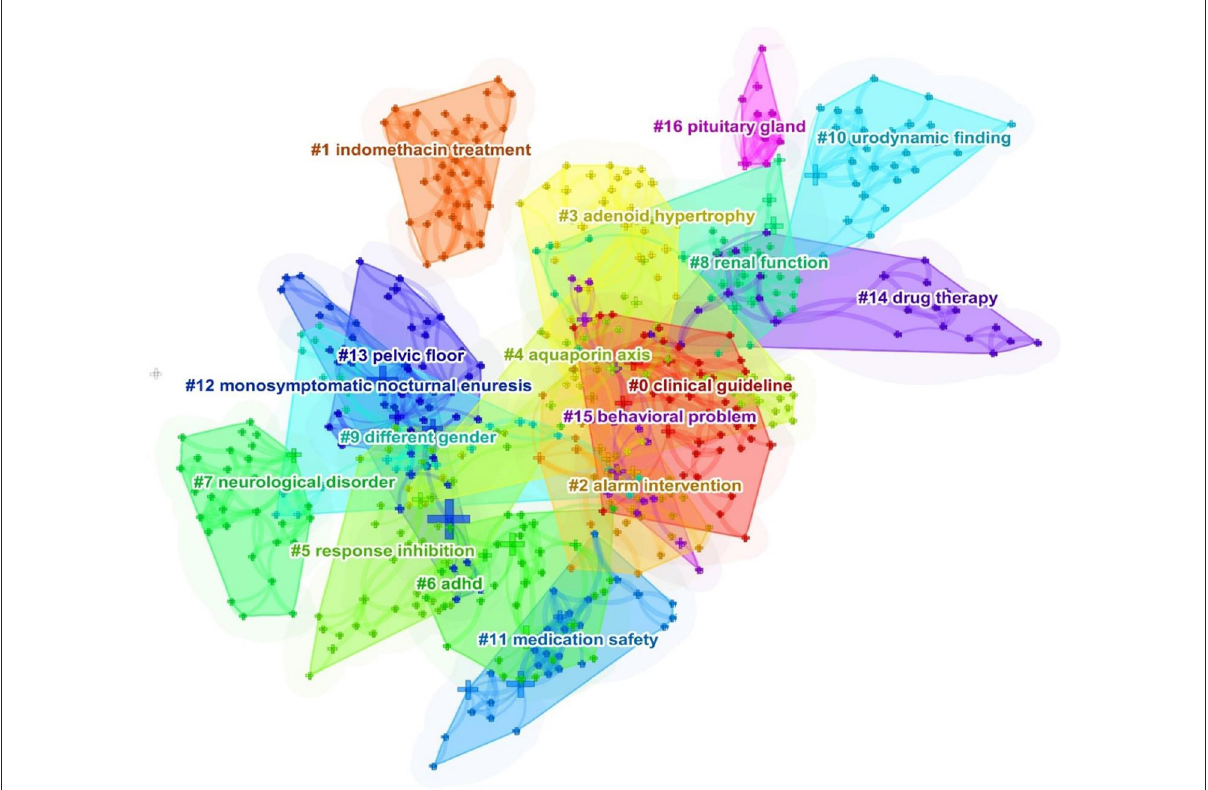
FIGURE7 Clustered networks of keywords. Each color represents a cluster. The smaller the clustering label, the more articles in the cluster (Q = 0.765, S = 0.905).